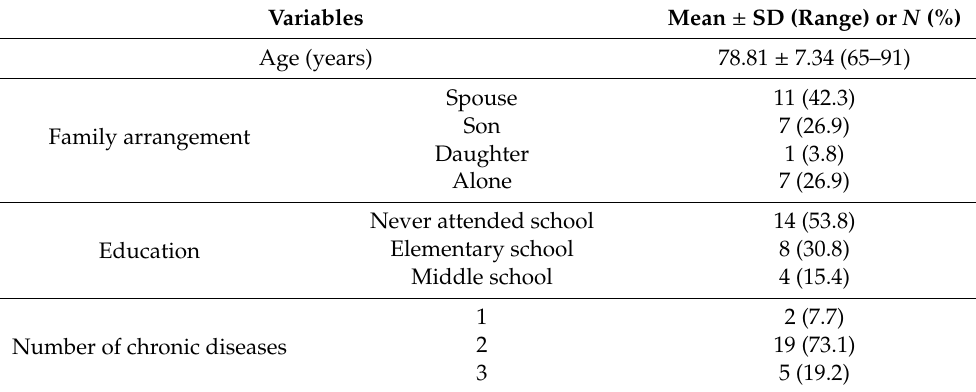
Table 2. General characteristics of the research participants ( N =